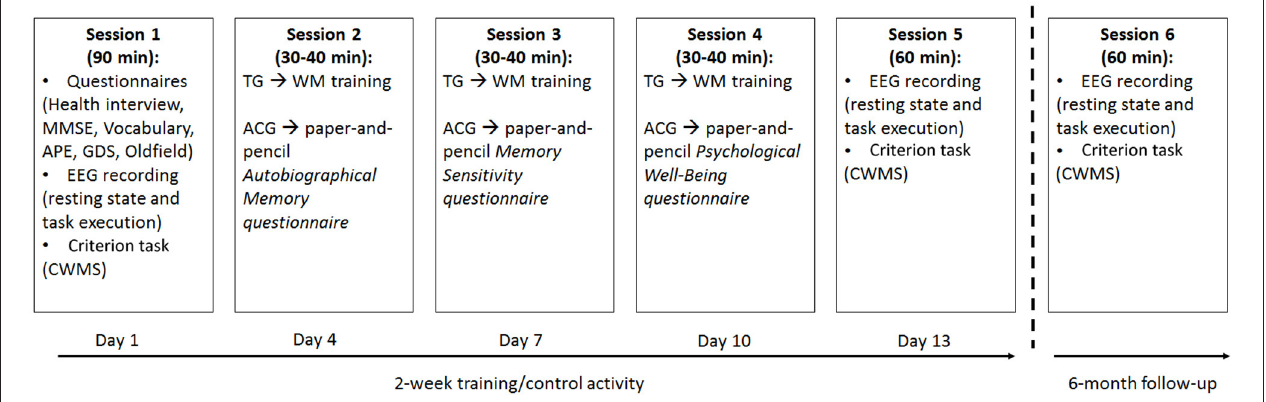
FIGURE 1 | Schematic representation of the 2-week training/alternative activity sessions assigned to the training group (TG) and active control group (ACG) participants, as well as the 6-month follow-up. TG: Trained Group; ACG: Active Control Group; MMSE: Mini Mental State Examination; GDS: Geriatric Depression Scale; CWMS: Categorisation Working Memory Span Test; APE: Ability to Solve Problems in Everyday Life